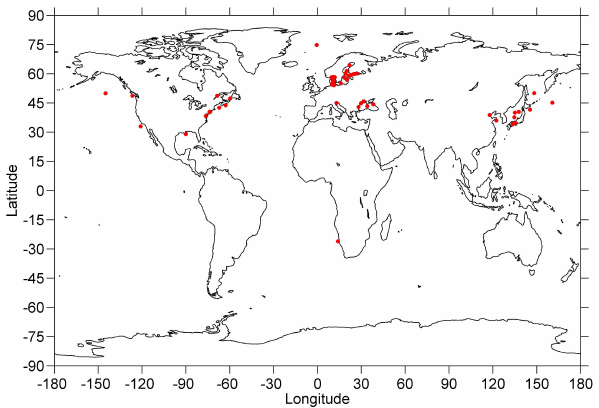
Fig. 3. Station locations (red dots) of oxygen concentration time series calculated from a global oxygen